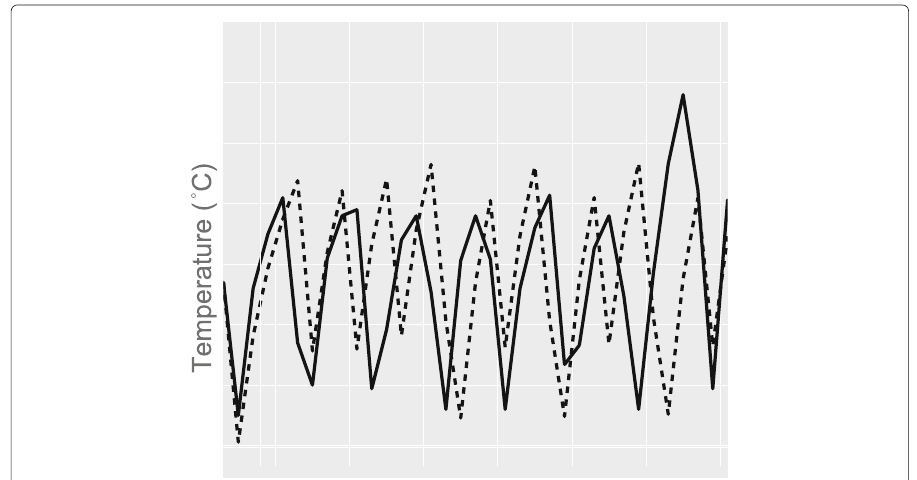
Fig. 4 Simulation Results. The hard line indicates the actual room temperature and dotted line indicates the predicted room temperature